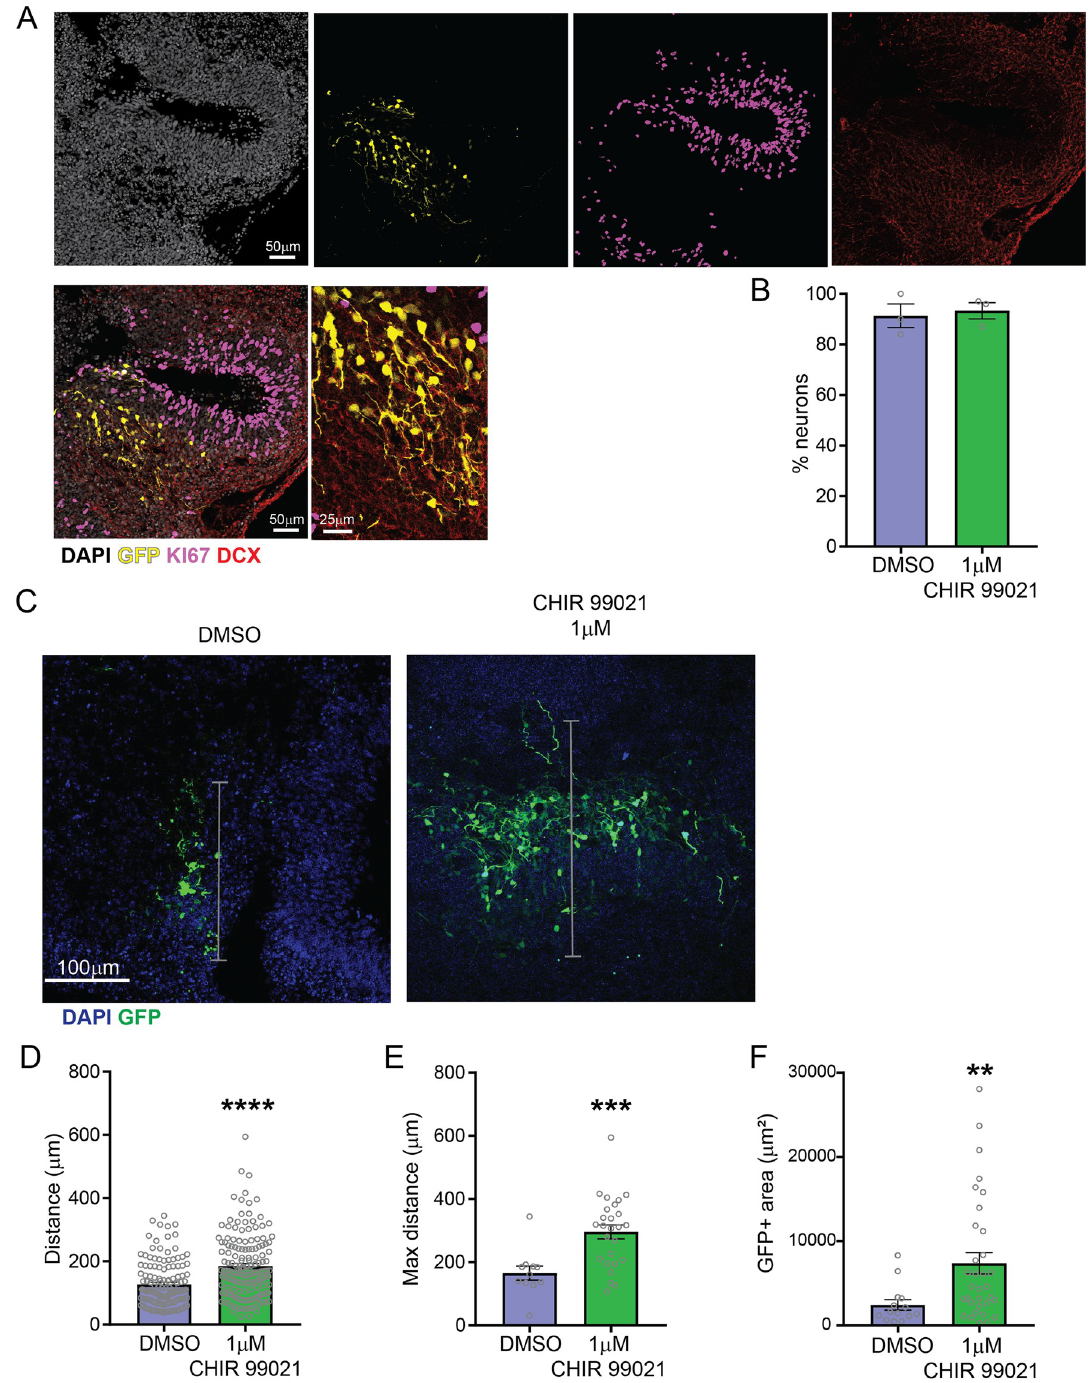
Fig 5. GSK3 β inhibition by CHIR 99021 increased neuronal migration. A . Representative images of GFP expressing cells 7 days after injection and electroporation of the GFP expression plasmid, with immunostaining of proliferative cell marker KI67 and neuronal marker DCX. B . Quantification of the percentage of neurons (DCX+, KI67- cells) (DMSO: 91.33% ± 8.083, n = 3; 1 μ M: 93.33% ± 5.508, n = 3; p-value = 0.7411, unpaired t-test) C . GFP positive area, distance and maximum distance (in gray) from injection ventricle were measured. D . Quantification of cell distance from injected ventricle (DMSO: 127.2 ± 6.189, n = 135; 1 μ M: 184.9 ± 8.041, n = 157; ���� : p- value < 0.0001, Welch’s t-test). E . Quantification of maximum distance from injected ventricle (DMSO: 165.4 ± 22.58, n = 11; 1 μ M: 295.5 ± 21.81, n = 26; ��� : p-value = 0.0003, Welch’s t-test). F . Quantification of area occupied by GFP positive cells (DMSO: 2435 ± 616.5, n = 14; 1 μ M: 7379 ± 1285, n = 33; �� : p-value = 0.0011, Welch’s t-test). Bar graphs represent mean ± SEM.